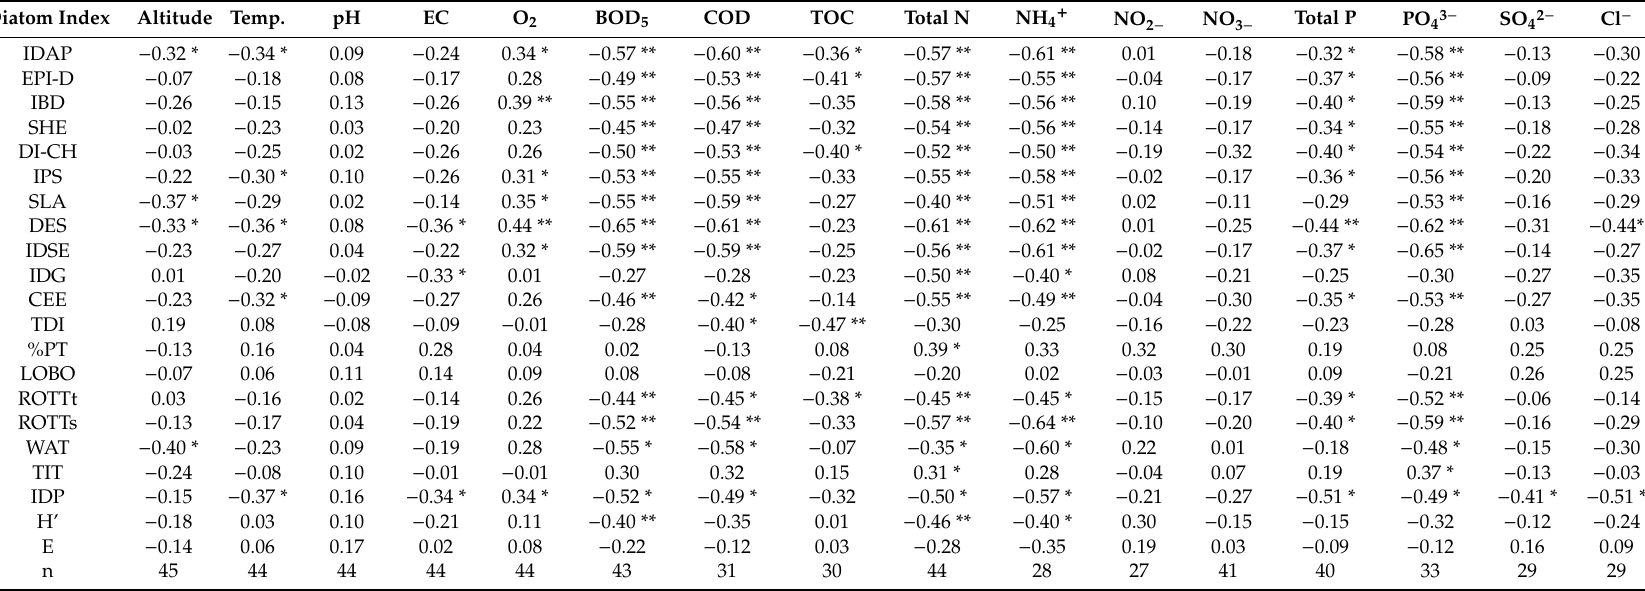
Table 6. Pearson correlations between diatom indices and physico-chemical parameters of water and sampling station altitudes (* p < 0.05, ** p < 0.01): Temp.—water temperature, EC—electrolytic conductivity, BOD—biochemical oxygen demand, COD—chemical oxygen demand, TOC—total organic carbon, H’—Shannon Diversity index, E—Evenness index, n—number of